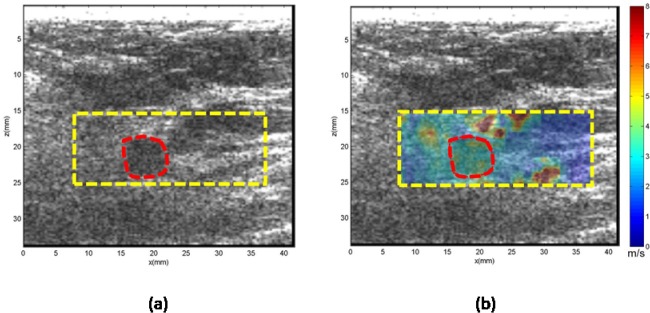
US and CUSE shear wave speed map of breast tissue (dashed yellow contour) including the breast mass ROI (red dashed contour).(a) B-mode US image. (b) CUSE shear wave speed map.